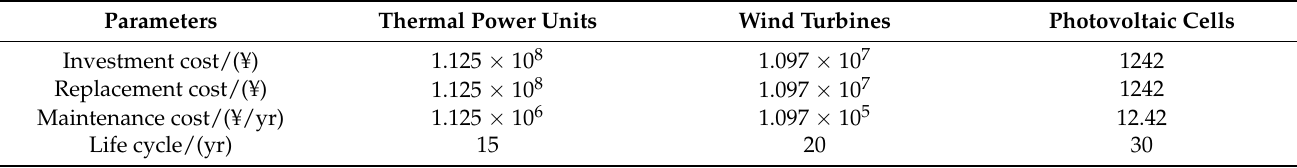
Table A4. System component costs and life